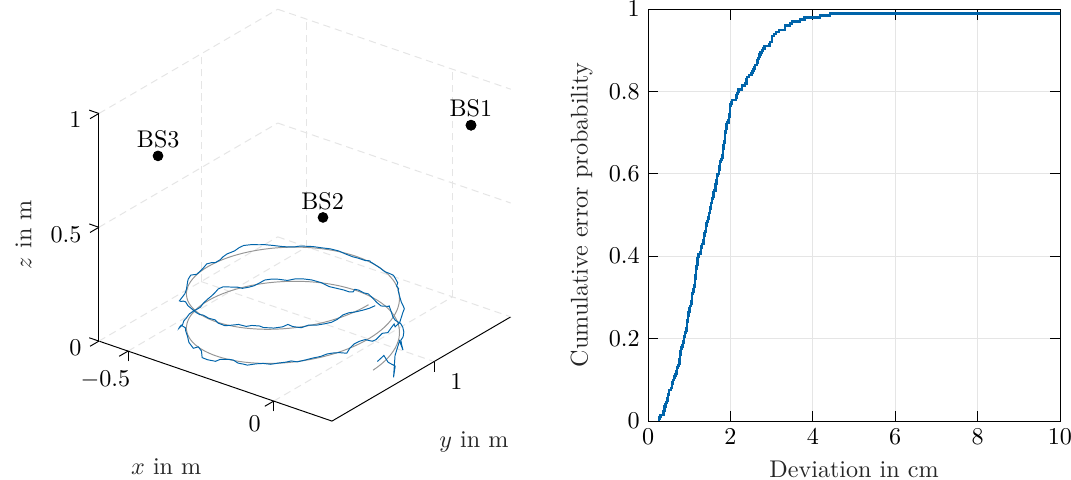
Figure 8. 3Dviewoftheideal(gray)andmeasured(blue)trajectoriesandcumulativeerrorprobabilityfunction.